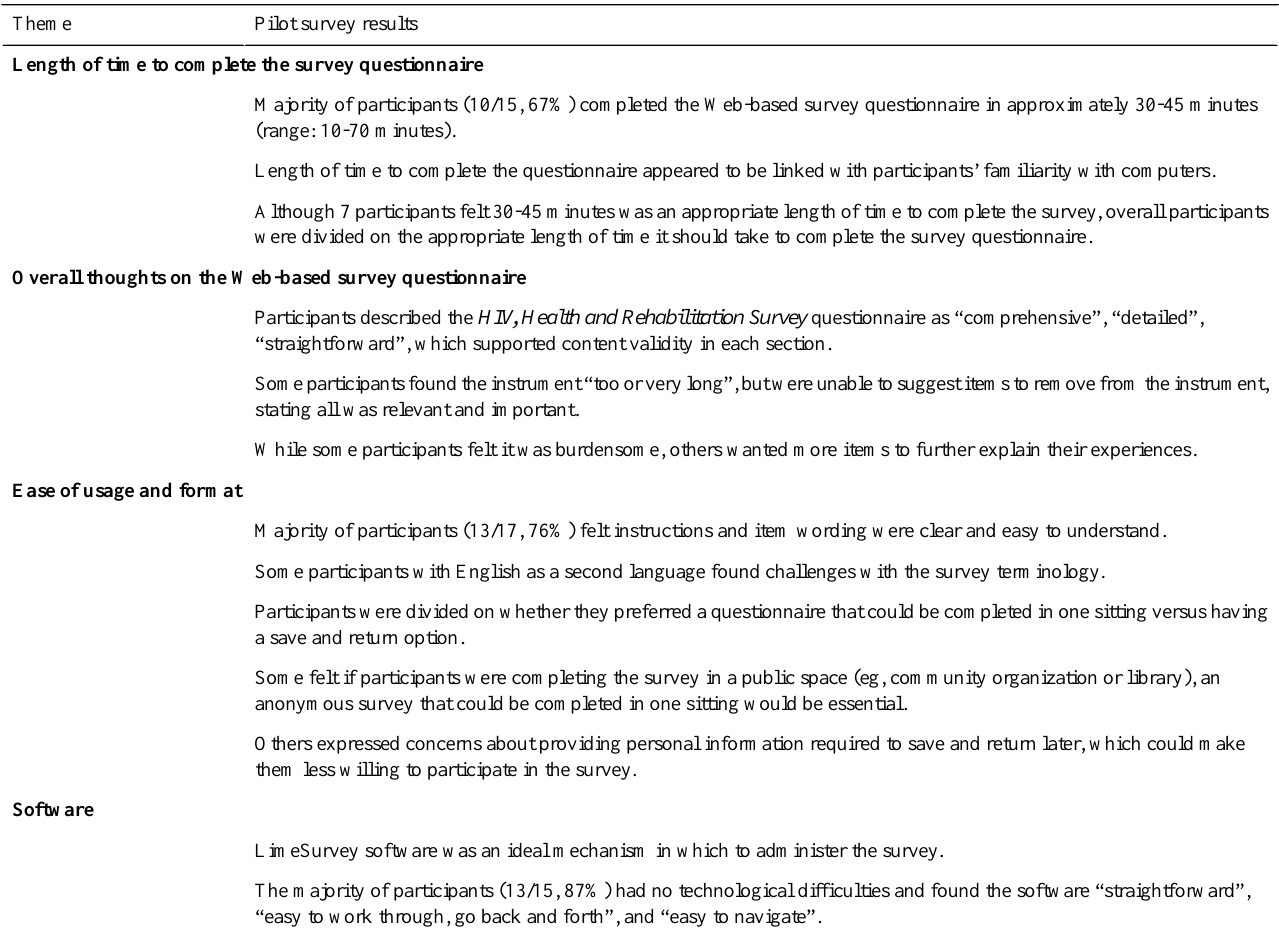
Table 2. Participants’perspectives on the survey instrument and process a